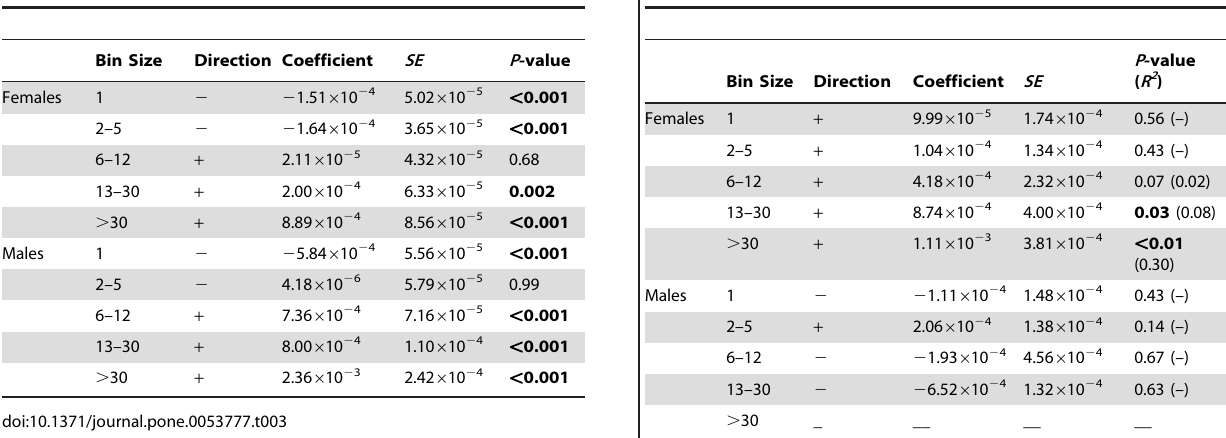
Table 4. Regression of group dispersion (binned by size) as a function of population size for elk in Riding